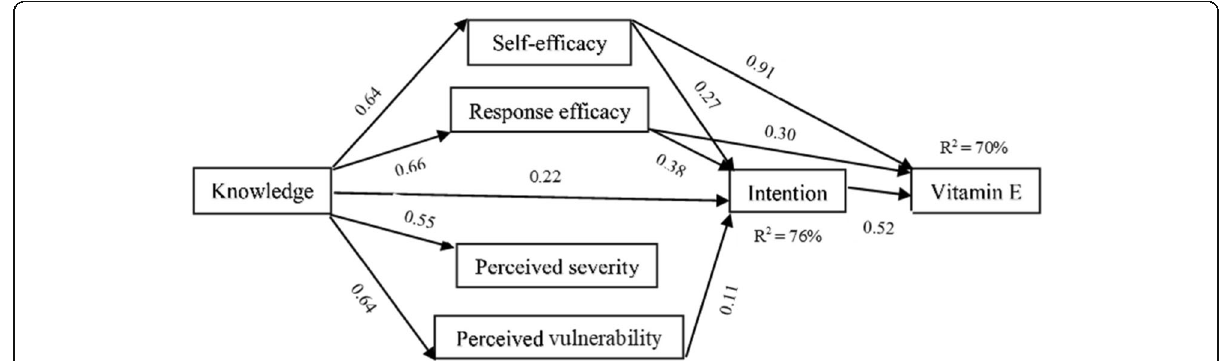
Fig. 3 PMT path model showing the significant standardized beta coefficients of vitamin E